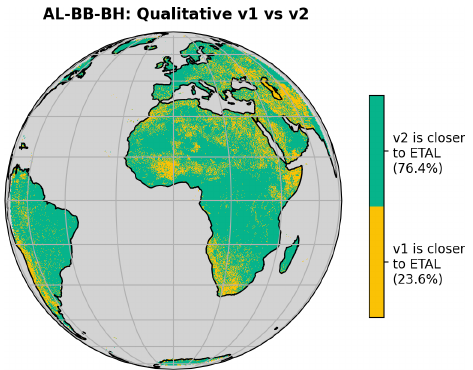
Figure 7. Qualitative comparison of performance of MDAL v1 and v2 with respect to ETAL, for broadband white-sky albedo (AL-BB-